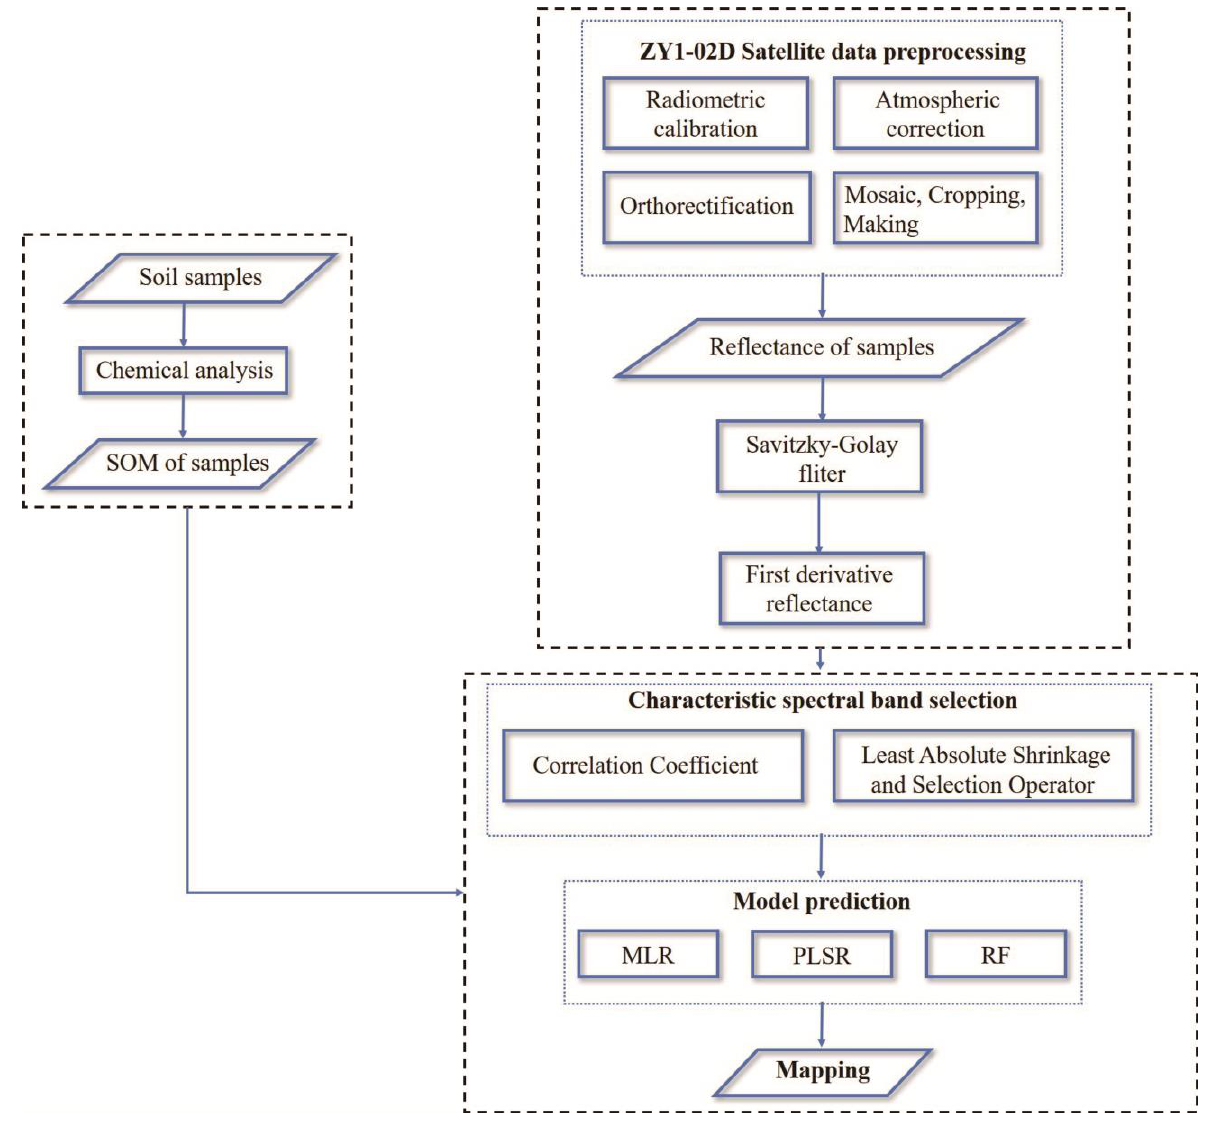
Figure 2. Flow chart.